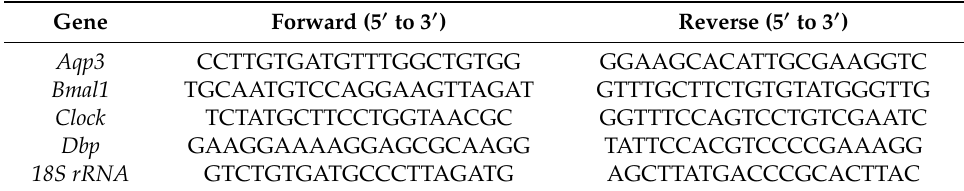
Table 1. Primer sequences for real-time